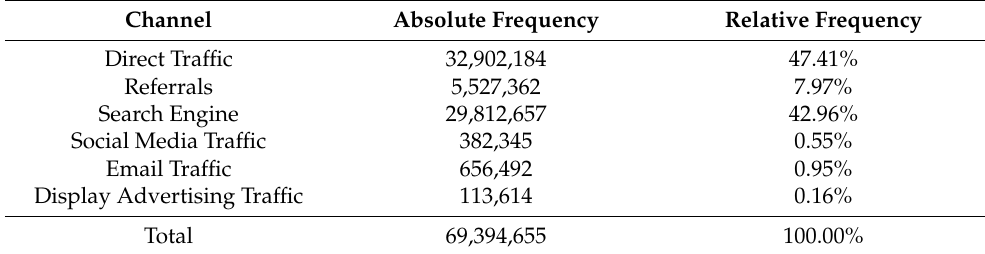
Table 3. Website traffic origin.